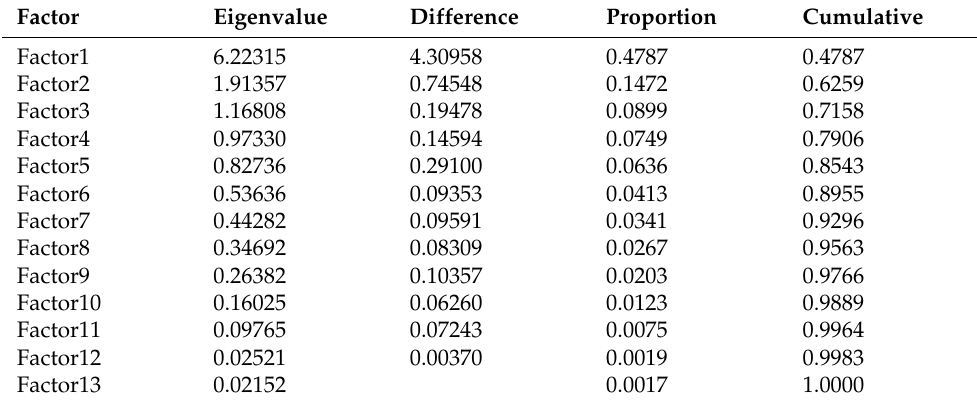
Table 4. Extraction of interpretation factors.